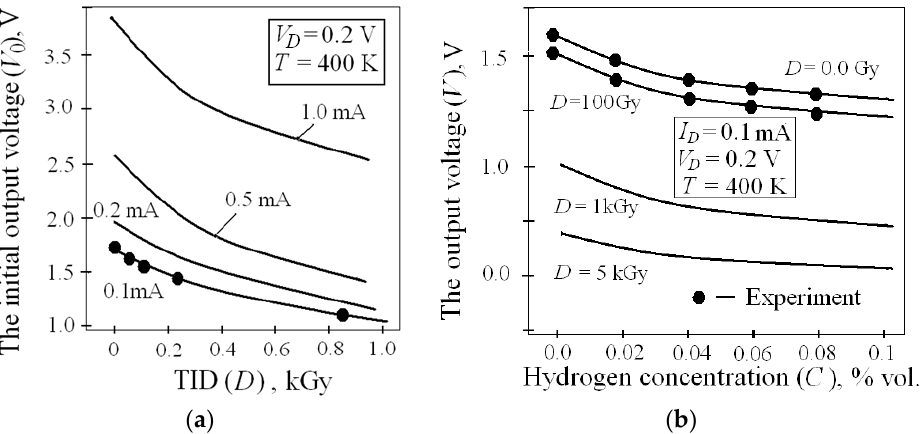
Figure 4. ( a ) The initial voltage V 0 vs. D at different drain currents for circuit No. 2; ( b ) The conversion characteristics V vs. C of circuit No. 2 for different